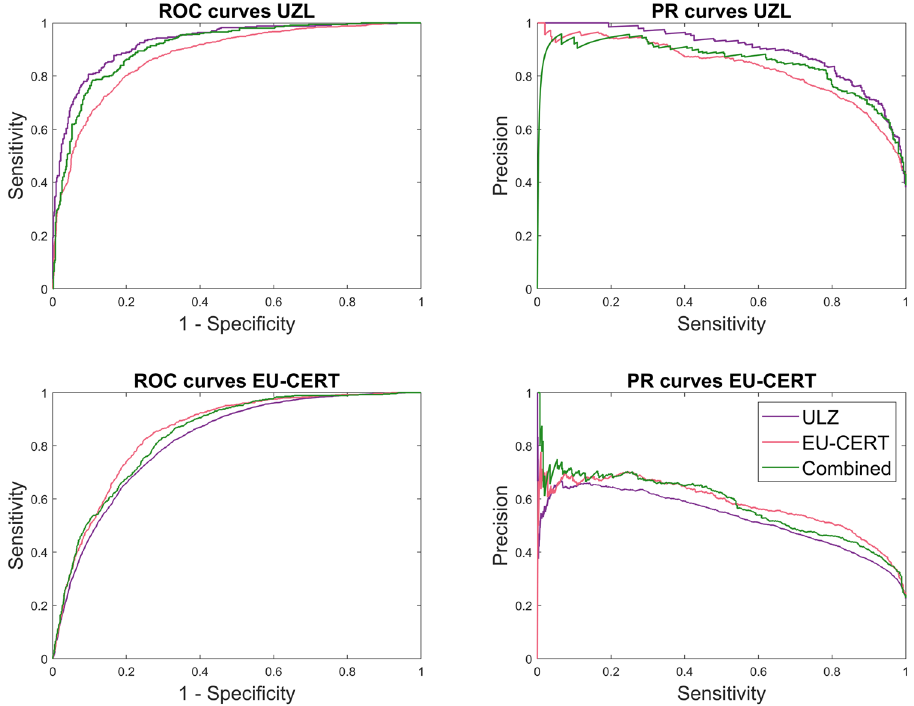
Figure 8. ROC and PR curves for test1 UZL and EU-CERT for the 3 training strategies considered.